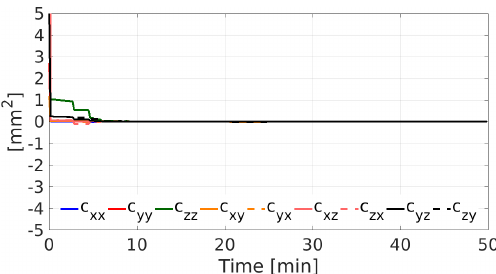
Figure 12. Covariance function over 50min for undifferenced am- biguity fixed kinematic positions (first 50min of day 091, 2007 ex- pressed in Earth-fixed reference